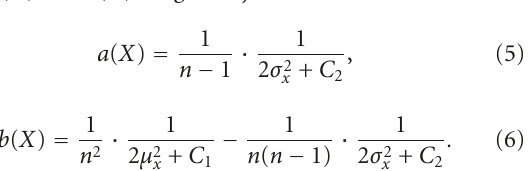
Table 1: Estimated (1 / 2 n ) E [log